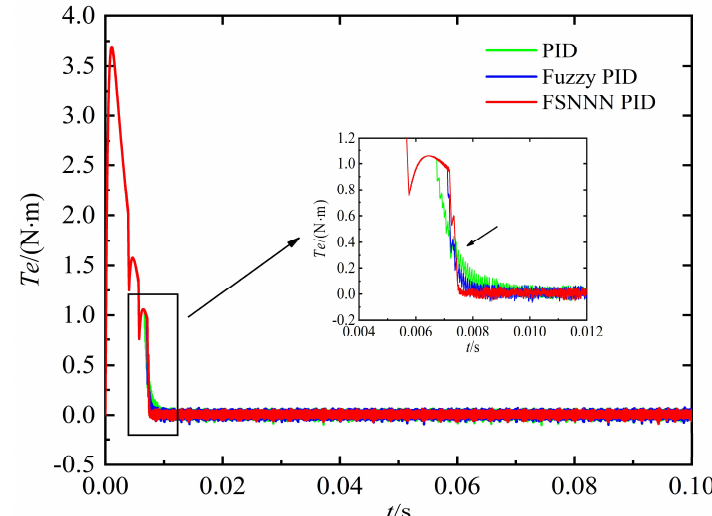
Figure 18. Electromagnetic torque T e curve.